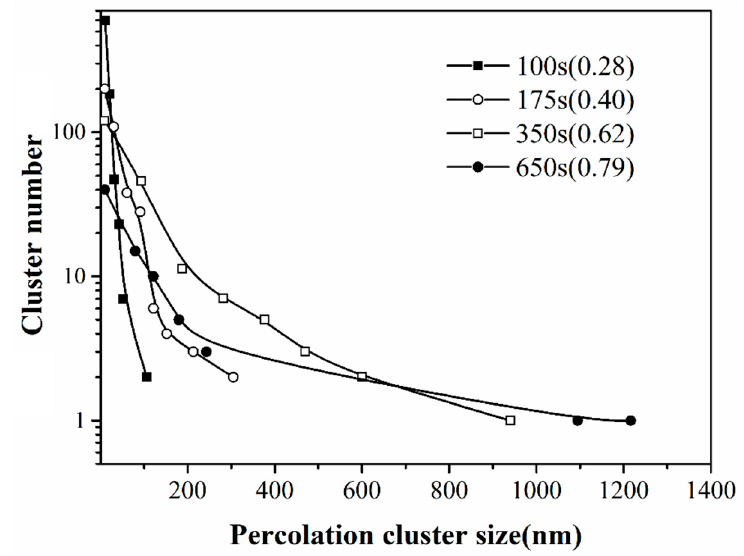
Figure 5. Size distributions of the percolation clusters analyzed from the TEM images of the Pd NP films with deposition time of 100 s, 175 s, 350 s and 650 s. The coverage of the NP films is shown in the corresponding legend.